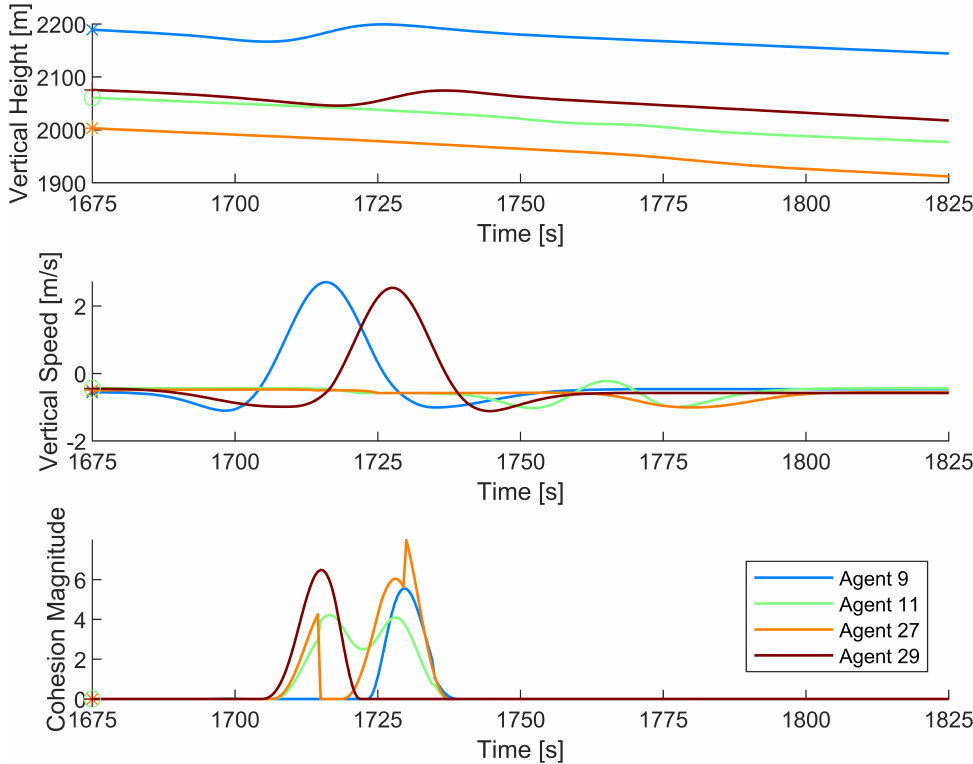
Figure 9. Vertical position, vertical speed, and cohesion magnitude data of agents 9, 11, 27, and 29, as they fail to effectively discover a thermal updraft. Agent 9 is marked with an ‘x’, agent 11 with an ‘o’, agent 27 with an ‘*’, and agent 29 with a ‘+’. The rendered path data starts at 1675 s and continues until 1825